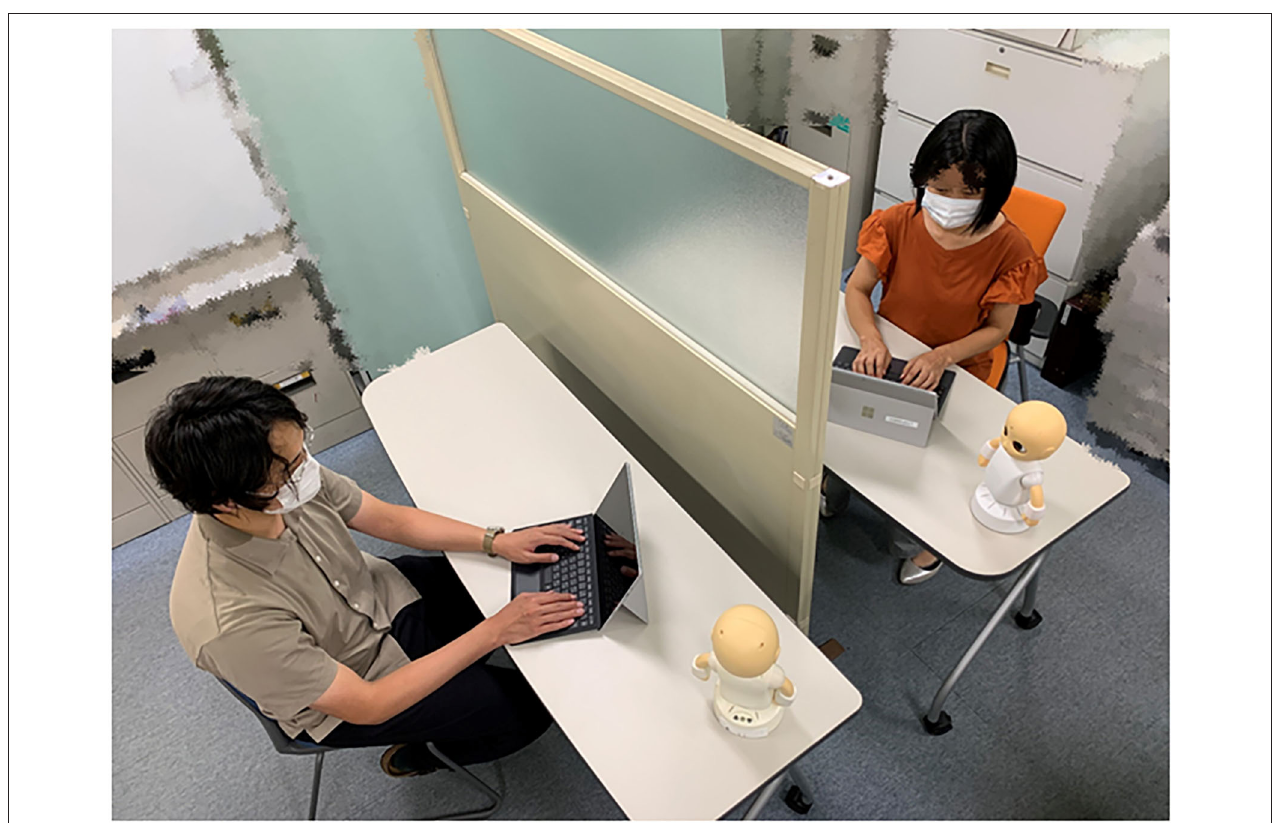
FIGURE 1 | Communication training system using a tele-operated robot. In this system, two participants were in the same room. We prepared a PC and a robot for each participant. Participants were grouped in pairs and communicated with each other through the tele-operated robot. For example, one participant input words into the computer, which were read aloud by the CommU in front of